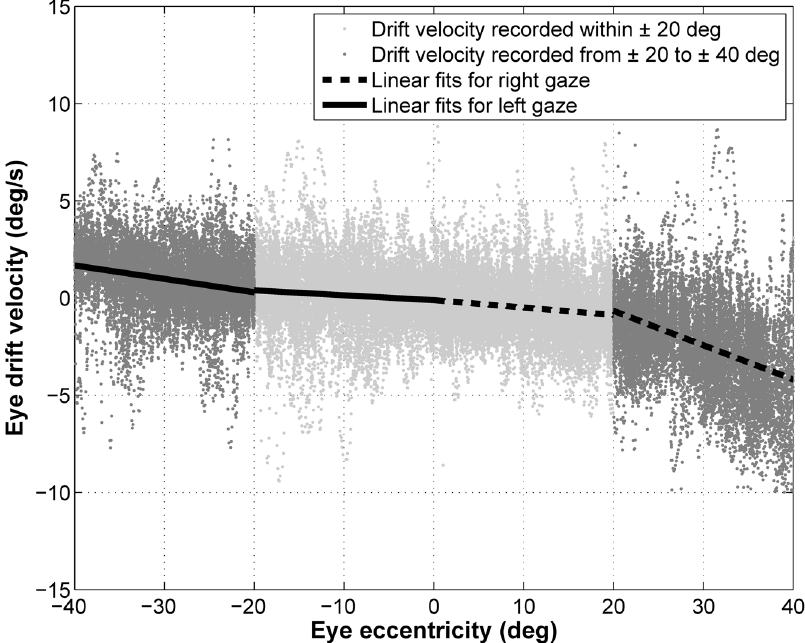
Figure 3. Position-Velocity plot and linear fit. Gray dots: Instantaneous velocity plotted as a function of the eye eccentricity. Light gray dots: Velocity in the 0–20 deg bins; dark gray dots: Velocity in the 20–40 deg bins; black line: linear fit of the velocity in the 0–20 deg bins and in the 20– 40 deg bins.